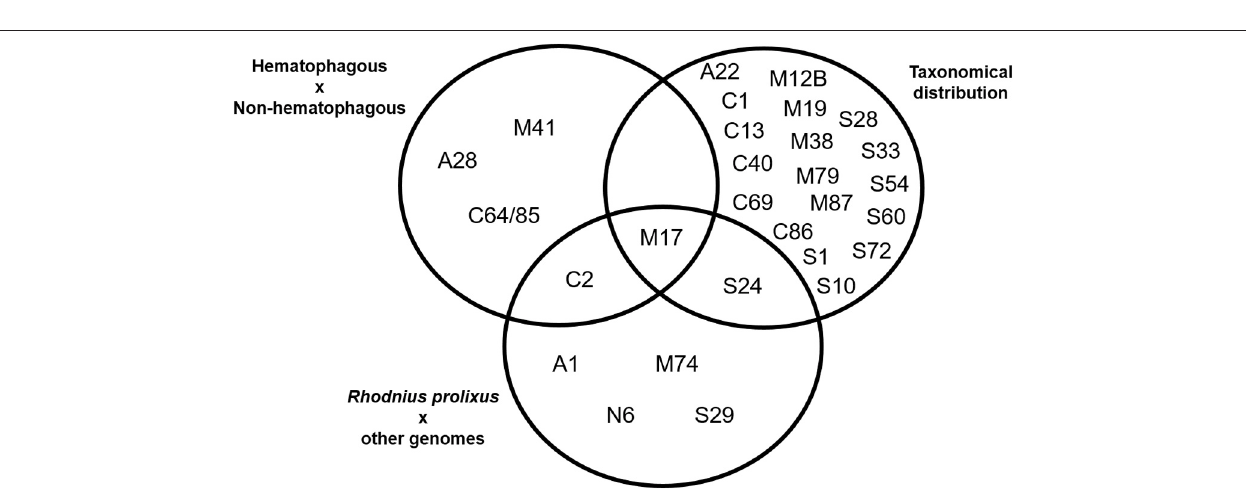
FIGURE 4 | Venn’s diagram of the clustering of MEROPS families after statistical analysis of peptidase gene frequencies in 19 arthropod genomes, including Rhodnius prolixus . Gene families with significantly higher/lower frequencies according to each criteria highlighted were included in each set. See Material and Methods for